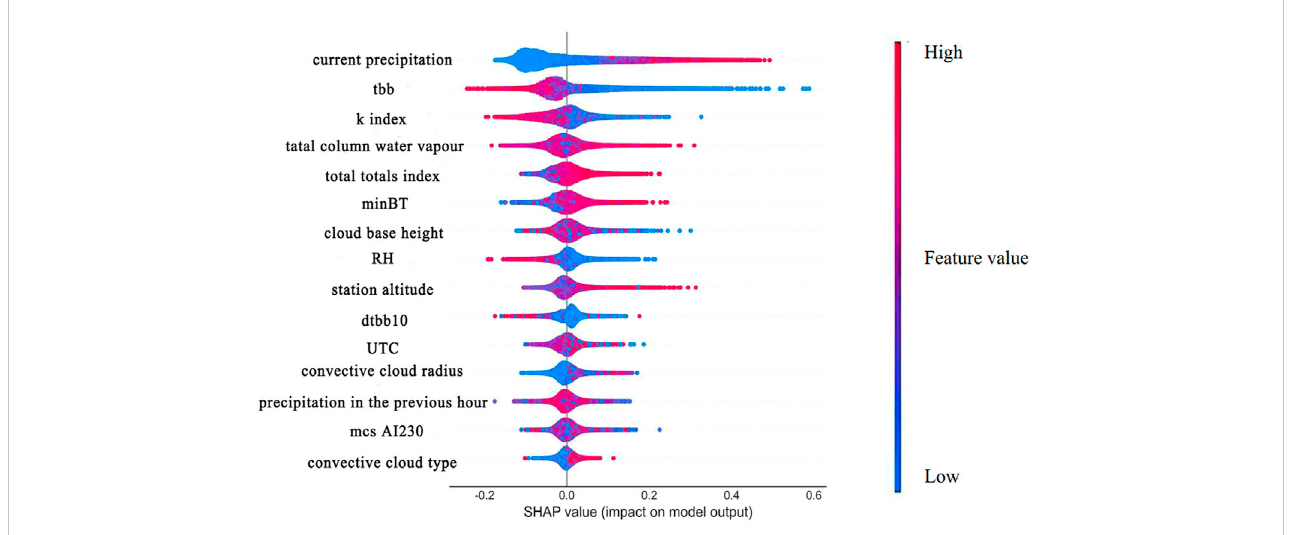
FIGURE 4 Summary plot of feature importance ranking and positive and negative in fl uence in